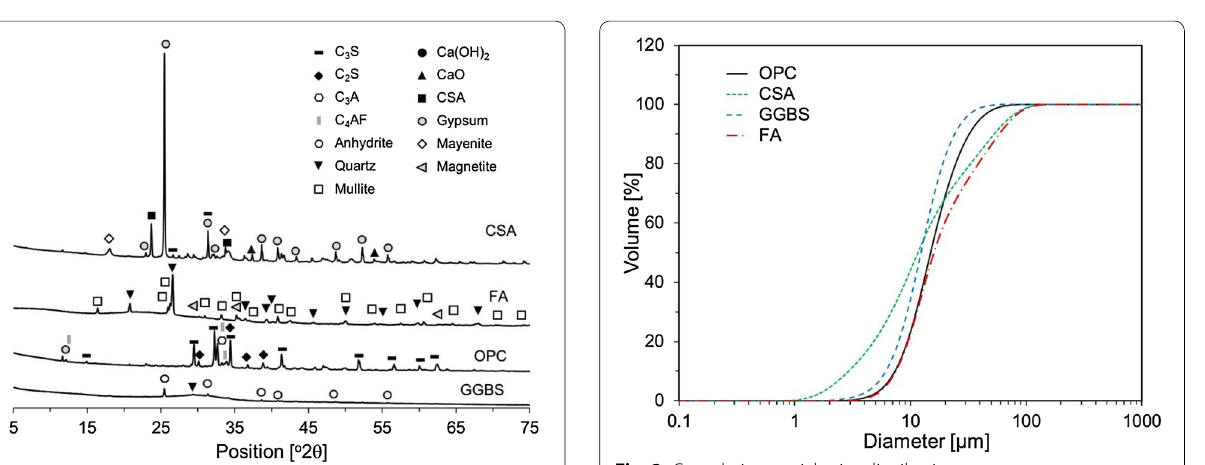
Fig. 2 Cumulative particle size